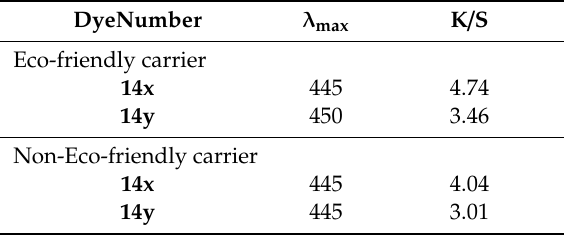
Table 3. Optical measurements of polyester fabrics dyed at 100 ◦ C.